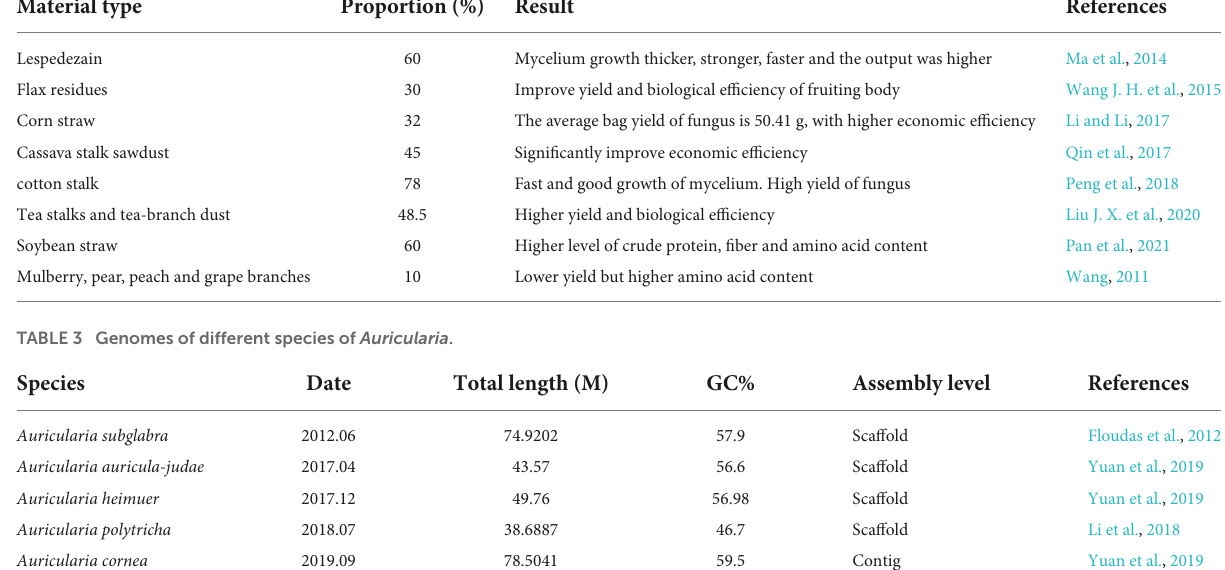
TABLE 2 Different formulations of Auricularia heimuer substitute cultivation.